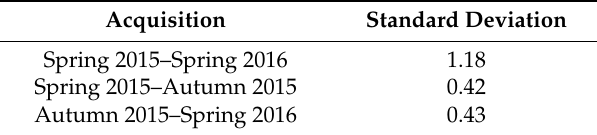
Table 3. Standard deviation of surface elevation difference over stable terrain.